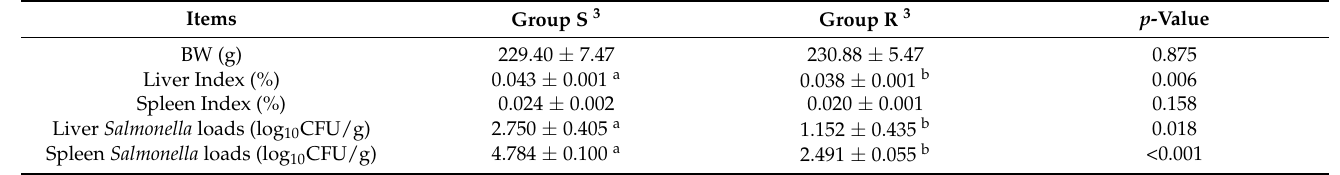
1 Tissue index: Percent of tissue weight relative to body weight. 2 Results are expressed as means ± SEM, with n = 8 per group. 3 Group S = selected S. enteritidis -susceptible chicks; Group R = selected S. enteritidis -resistant chicks. a,b In the same row, values with different letters are significantly different between two groups ( p <